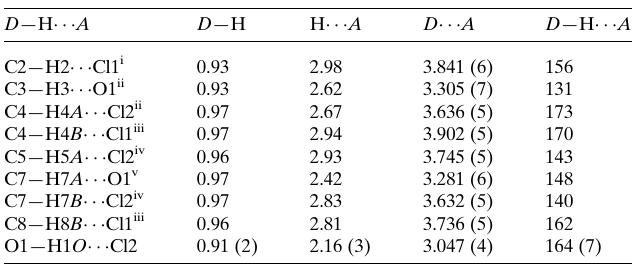
Table 1 Hydrogen-bond geometry (A˚ , (cid:5) ).